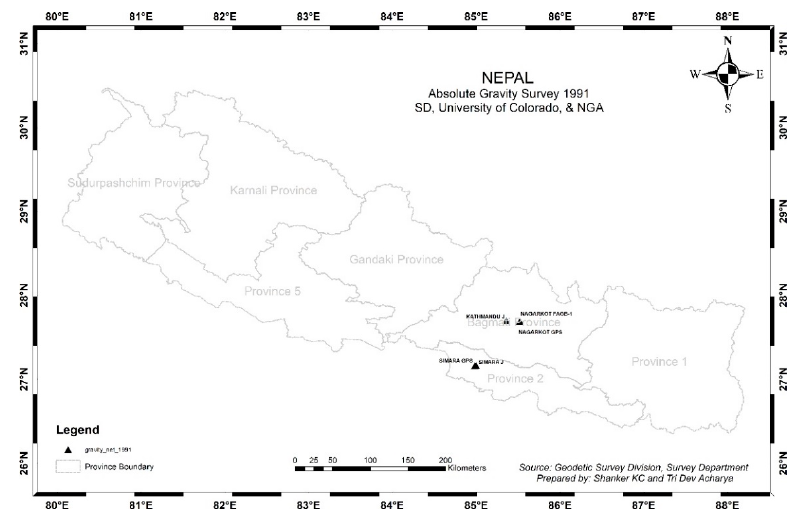
Figure 12. Absolute gravity survey 1991 [46].